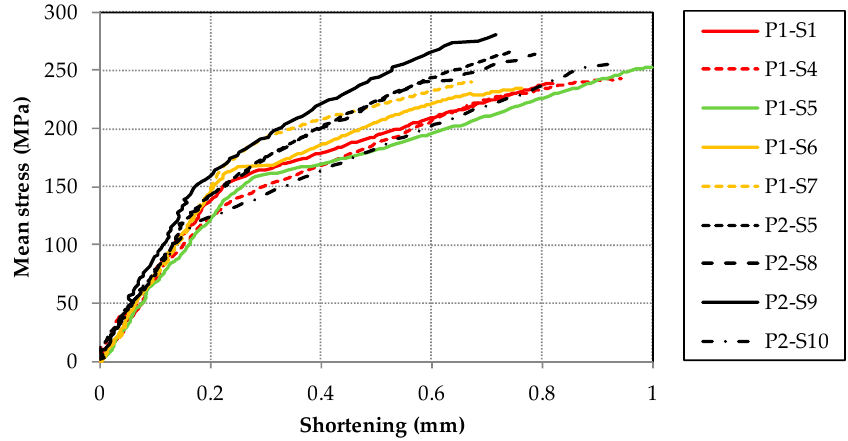
Figure 7. Mean stress versus shortening of specimens (for P2-S3 no digital imaging correlation data is available and the results for CAI-standard device are shown up to the maximum load).